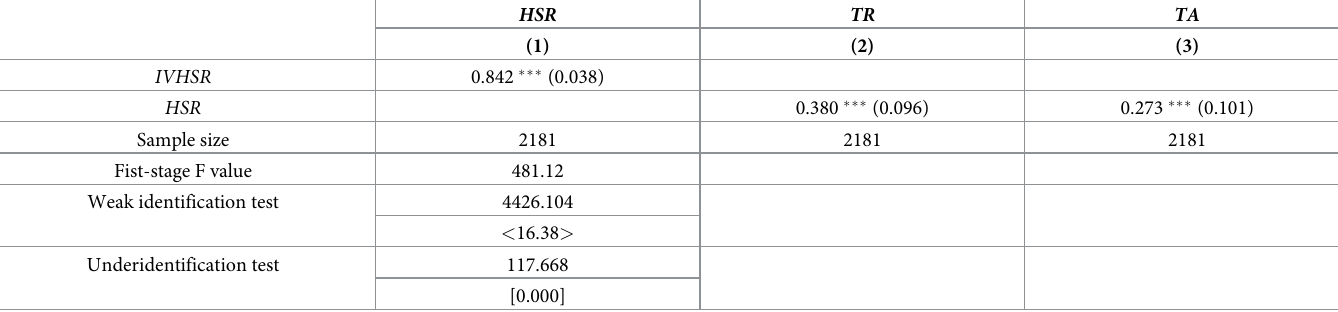
Table 3. Results from the IV